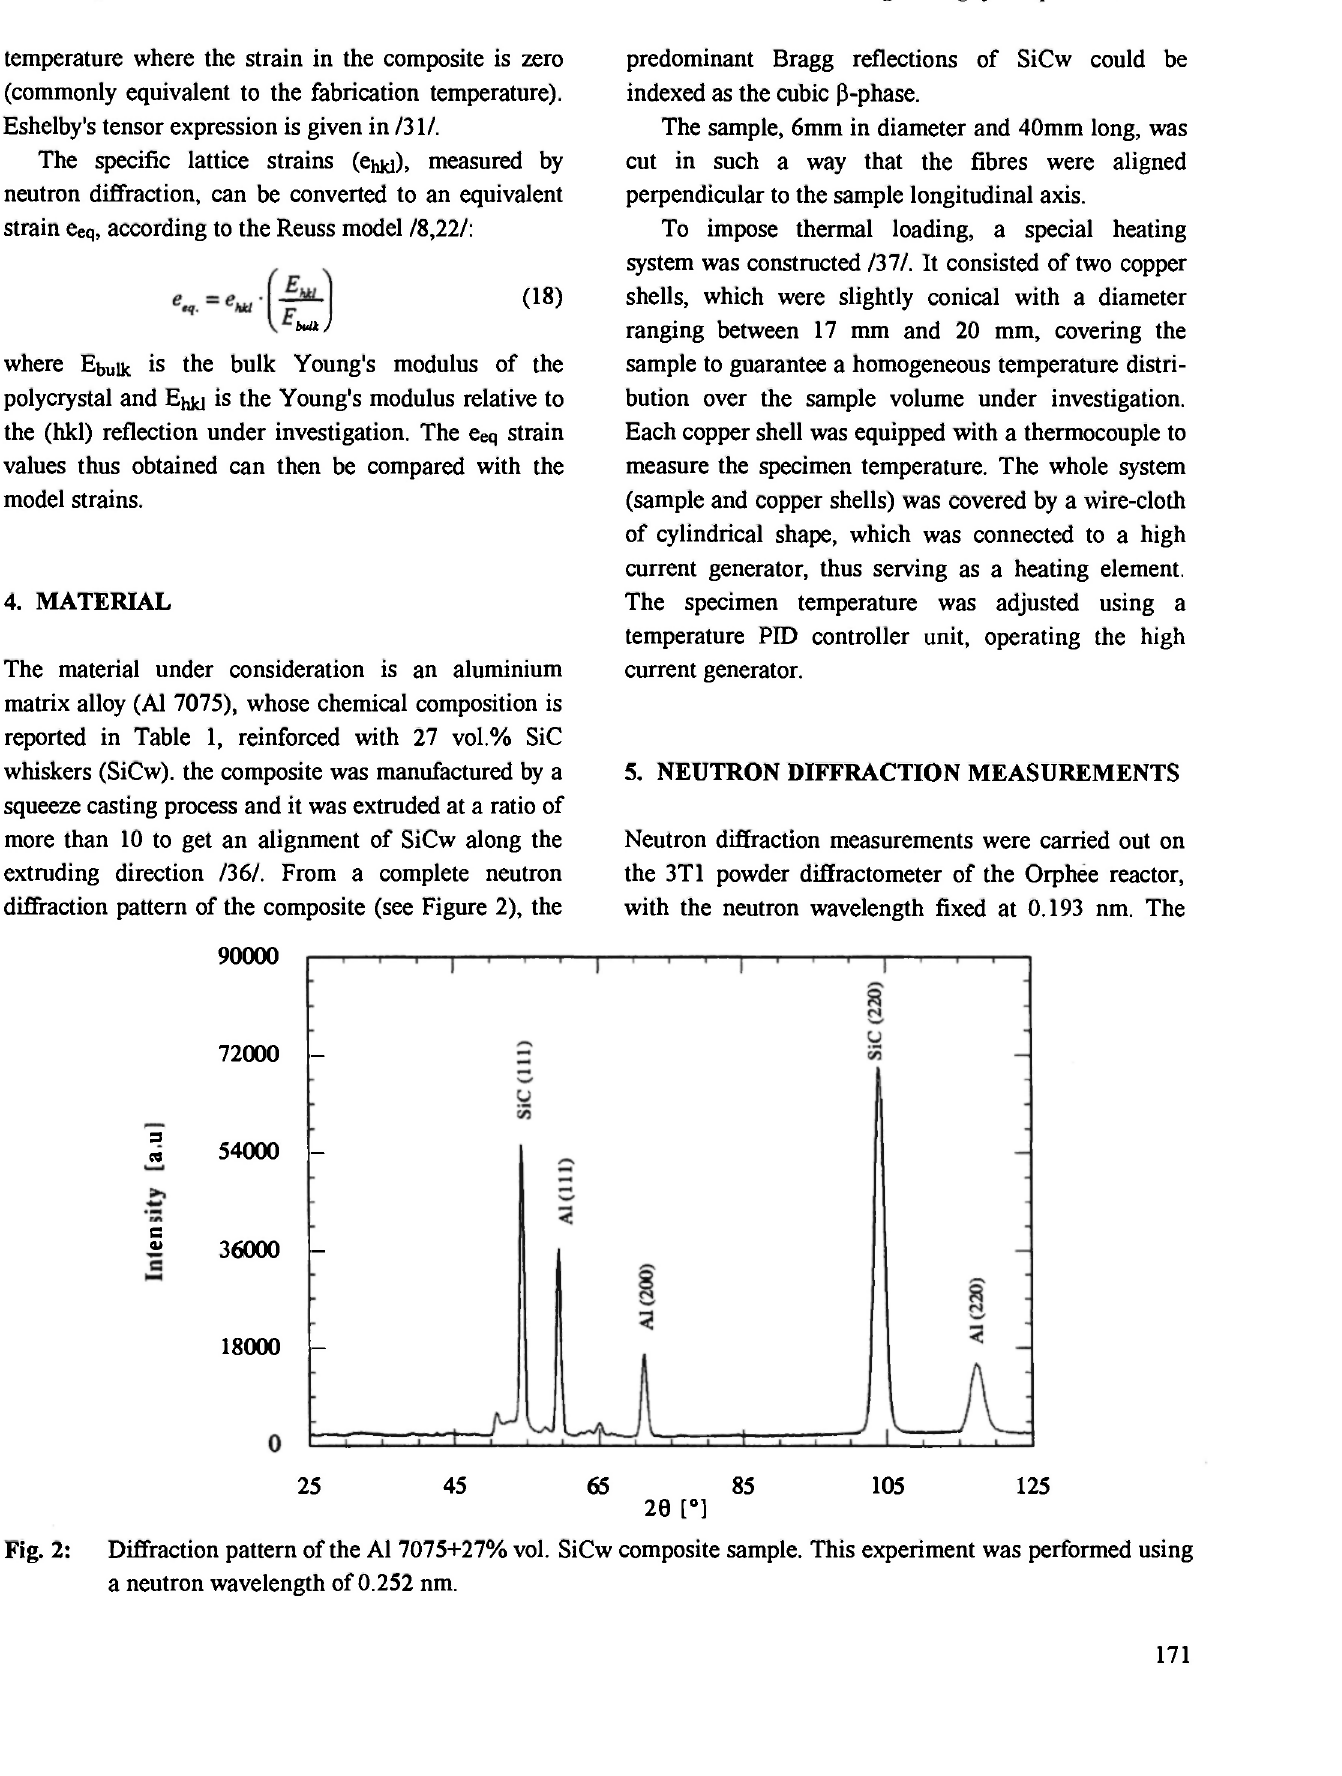
Diffraction pattern of the Al 7075+27% vol. SiCw composite sample. This experiment was performed using a neutron wavelength of 0.252